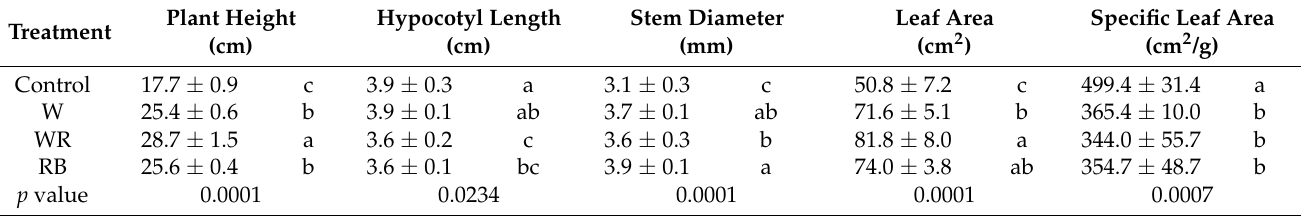
Table 2. Morphological traits of greenhouse-grown tomato seedlings grown under supplementary white LEDs, white plus red LEDs, and red plus blue LEDs, respectively, and tomato seedlings cultivated under sunlight only were regarded as the